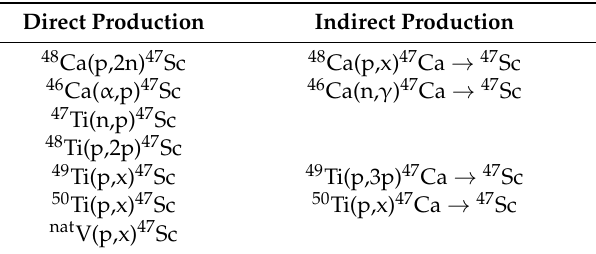
Table 3. Direct and indirect 47 Sc production